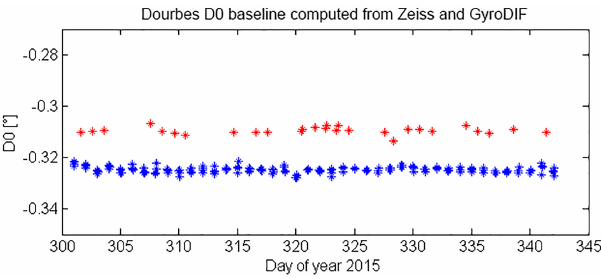
Figure 4. Baseline D0 comparison. Blue dots are computed from GyroDIF measurements. Red dots are computed from conventional DI-flux instrument (Zeiss